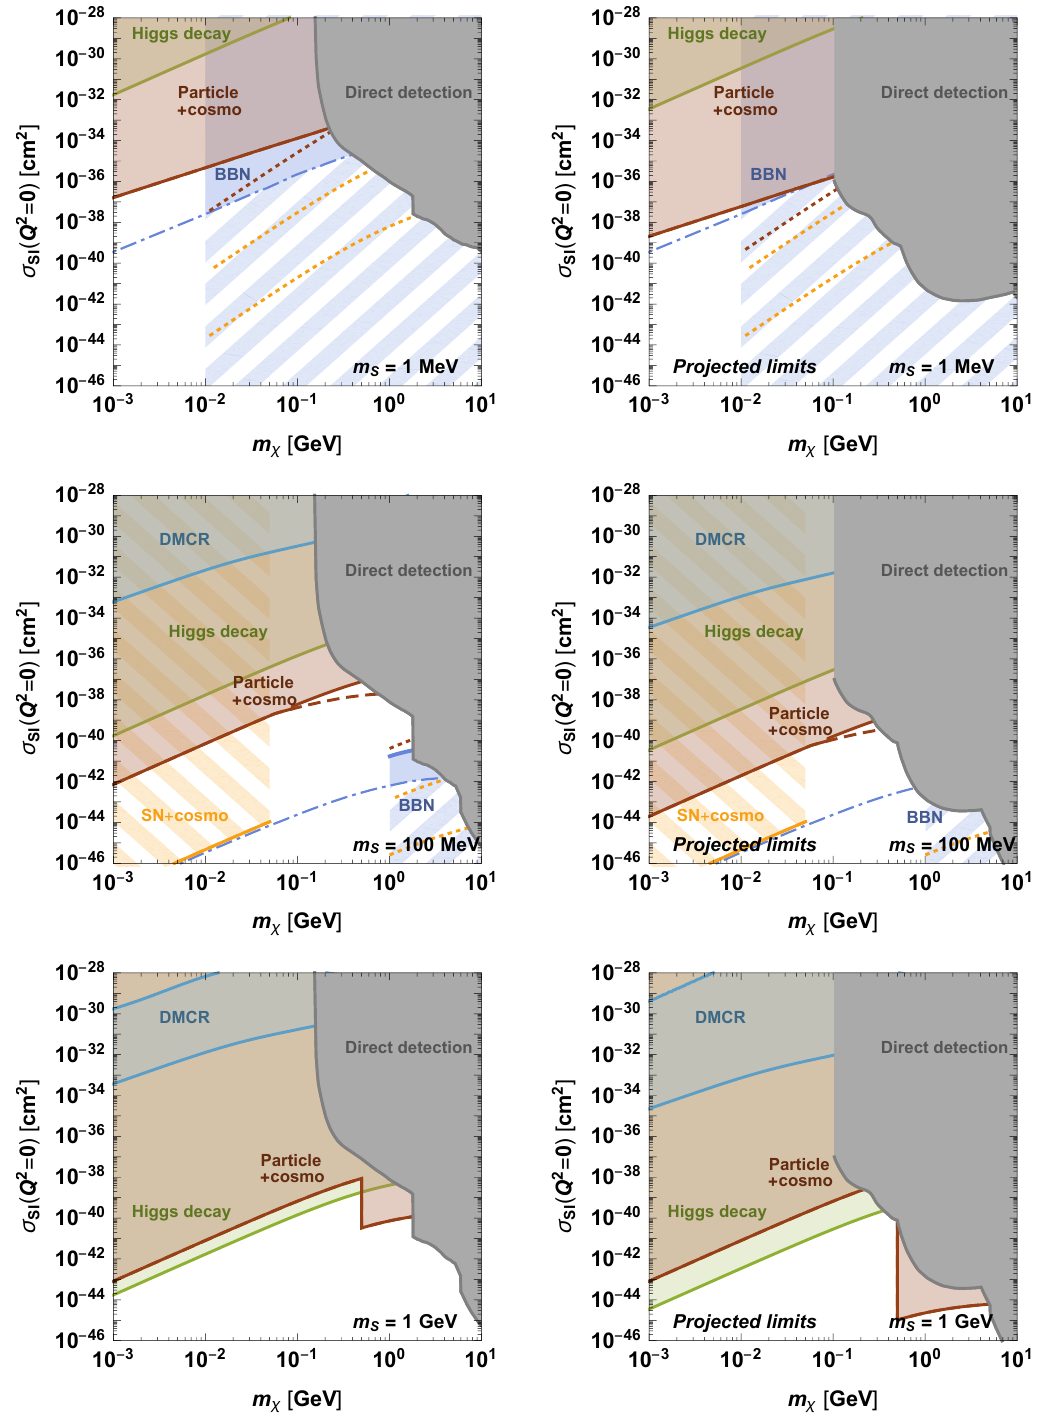
Figure 6 . Same as (cid:12)gure 5, for (cid:12)xed scalar masses m S . As in that (cid:12)gure, we do not display limits related to thermal production of DM in the kinematic regime where m S & 0 : 1 m (cid:31)